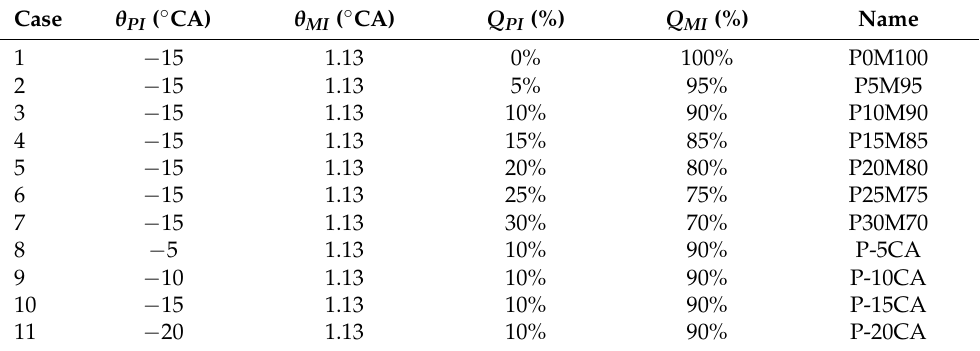
Table 9. Settings for various injection